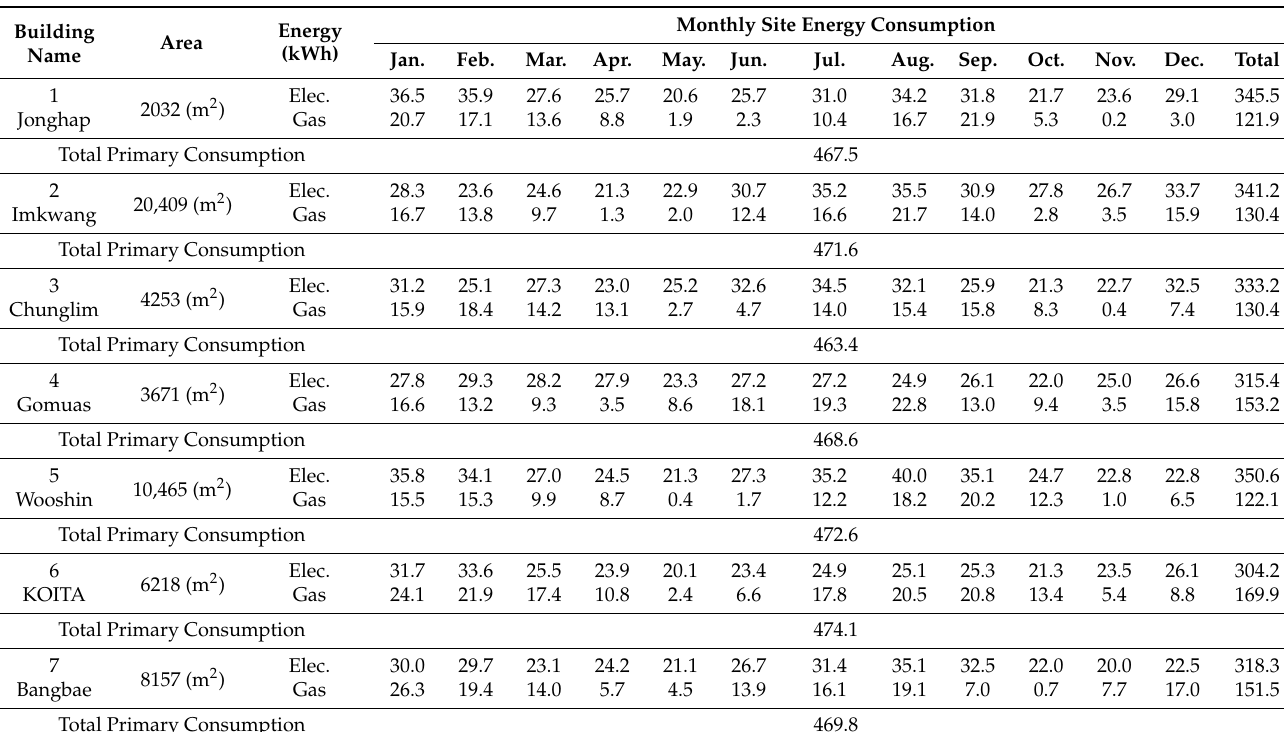
Table 3. The measurement data (primary energy consumption values) for selected Seoul metropolitan research office buildings.